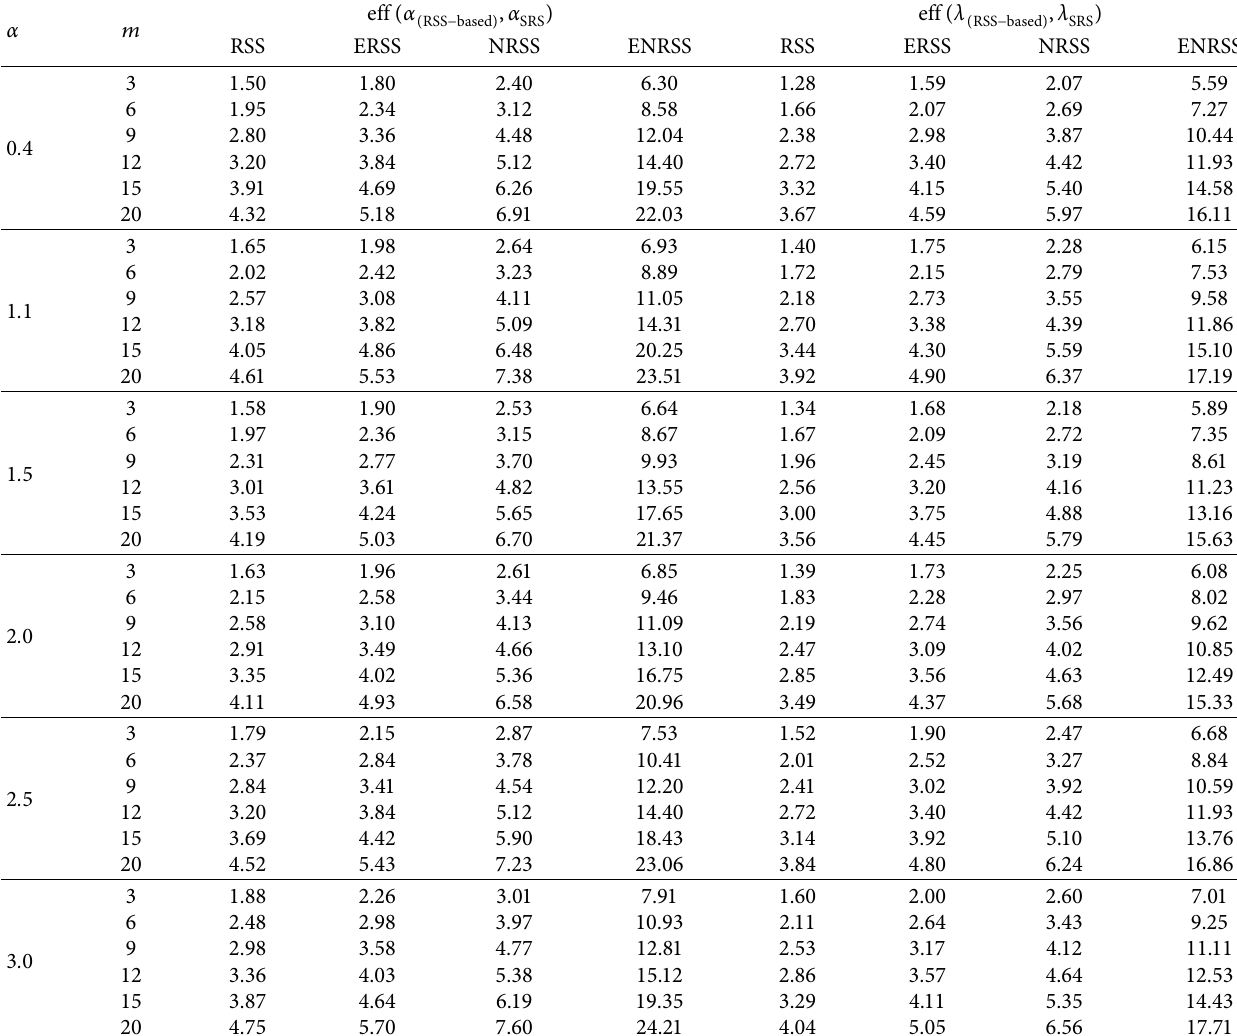
Table 1: Relative efficiency for RSS-based estimators for different sampling plans and INH distribution with scale parameter λ � 1. α